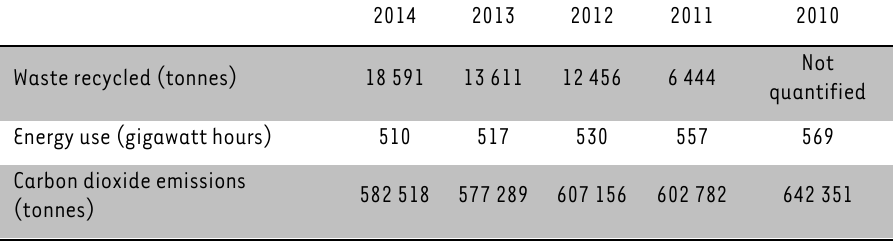
TABLE 9: Pick n Pay Environmental Initiatives from 2010 to 2014